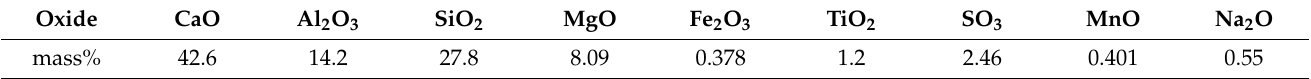
Table 1. Chemical composition of